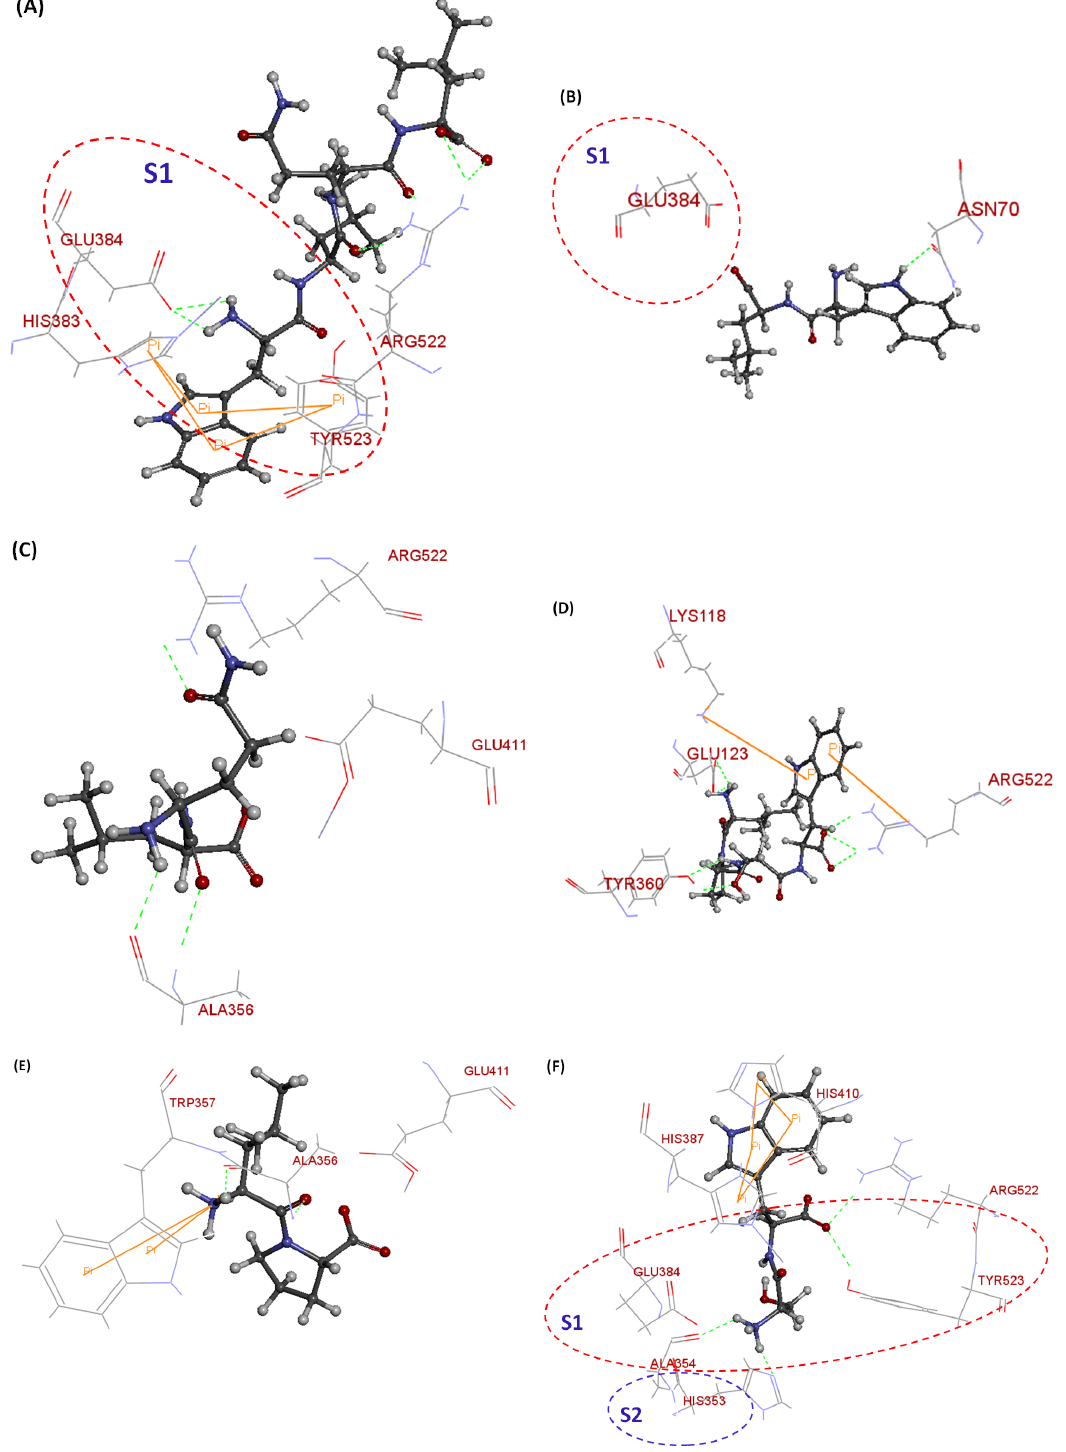
Figure 4. The interaction model of inhibitory peptides and the ACE receptor. The best docking poses of peptides are ( A ) WLQL, ( B ) WL, ( C ) QL, ( D ) LPSW, ( E ) LP, and ( F ) SW at the ACE pockets. The amino acid residues that belong to pocket S1 and S2 are shown via a red circle and blue circle, re ‐ spectively.